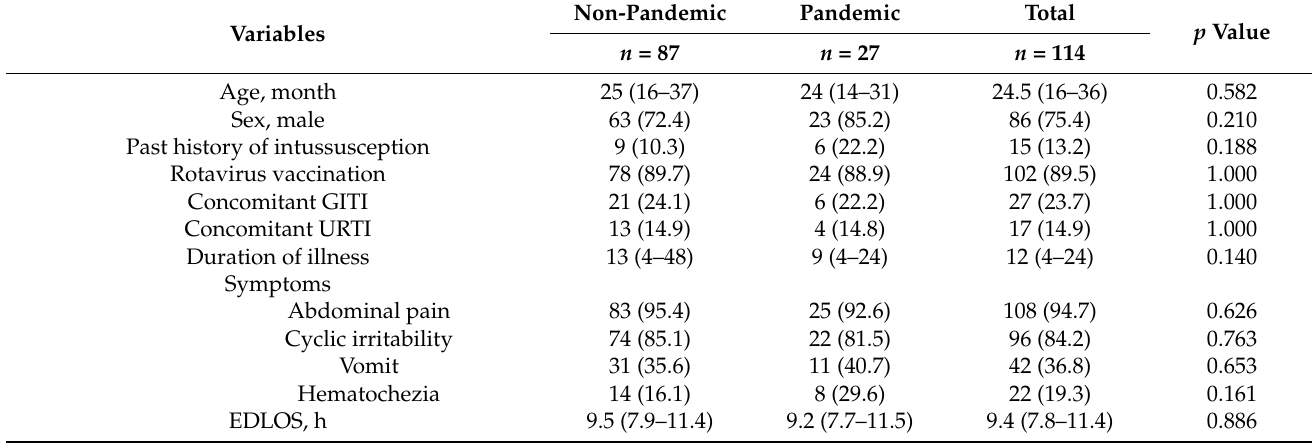
Table 2. Clinical characteristics of patients with intussusception before and after the COVID-19